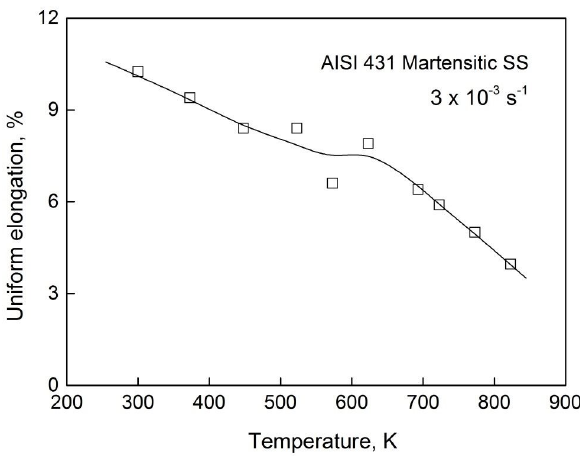
Figure 5: Variation of tensile ductility with temperature for the AISI 431 steel.